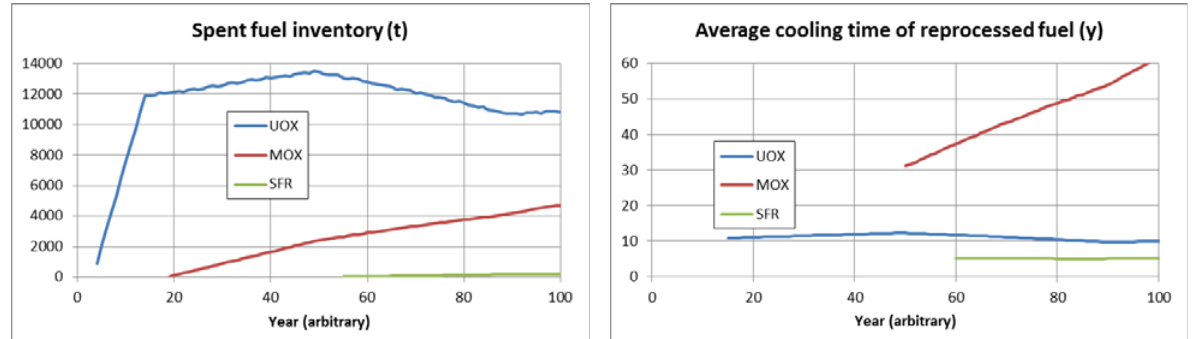
Figure 3. Spent fuel inventory and cooling time at